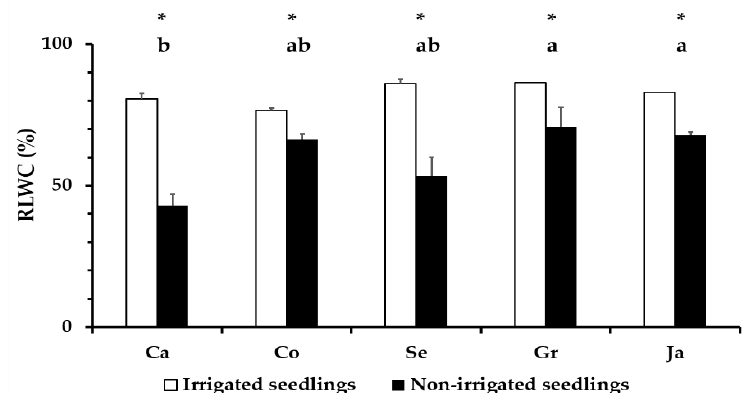
Figure 2. RLWC (Relative leaf water content) determined in seedlings of the Andalusian Q. ilex populations at day 25. Values are mean ± SE of three biological replicates. Statistically significant differences were observed between irrigated and non-irrigated seedlings. Different letters indicate that there is significant difference among populations ( p = 0.05 ) . Asterisk indicates significant differences between irrigated and non-irrigated seedlings (* p < 0.05).